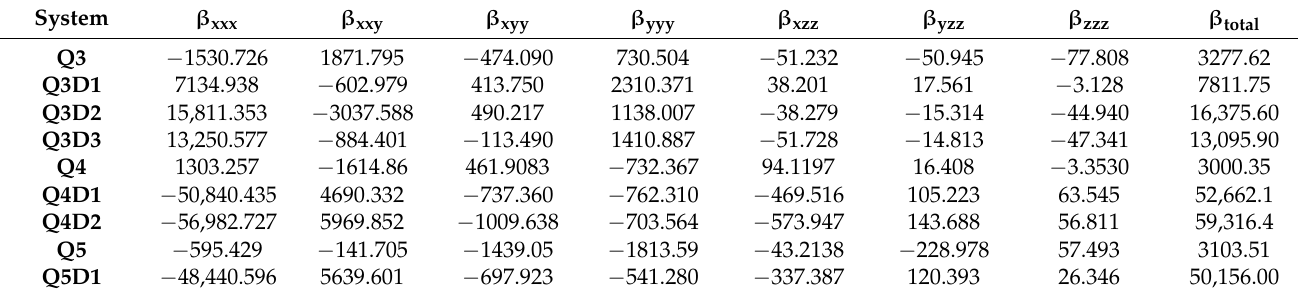
Table 4. The computed second-order polarizabilities ( β tot ) and major contributing tensors (a.u) of Q3 – Q5D1 .